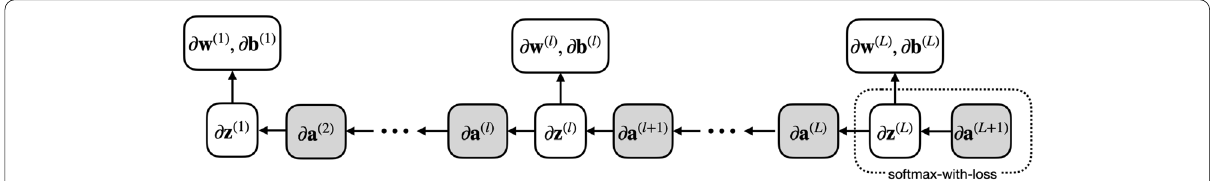
Fig. 4 BP process to train a neural network of L